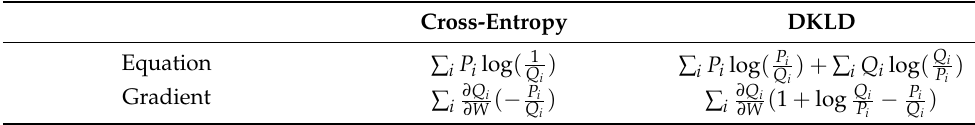
Table 2. Comparison between DKLD and cross-entropy.